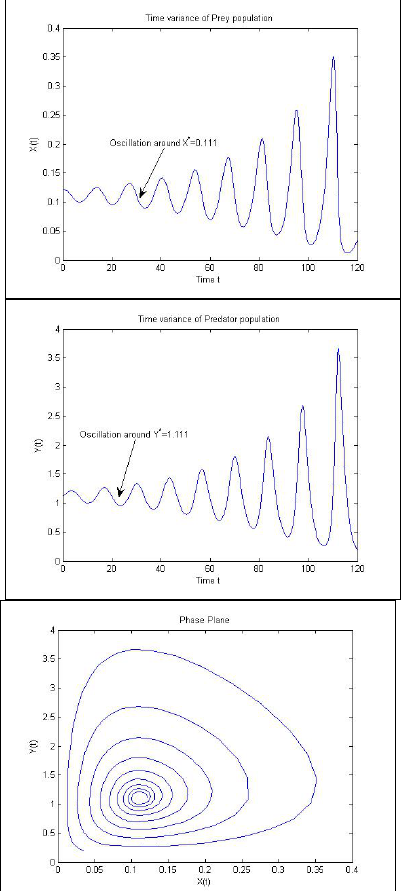
Fig. 4. The positive equilibrium is unstable for τ 1 = τ 2 = 0 and R = 10 > 1 .The system exhibits a spiral out from the equilibrium ( x ∗ 1 , y ∗ 1 ) = (0 . 111 , 1 . 111)